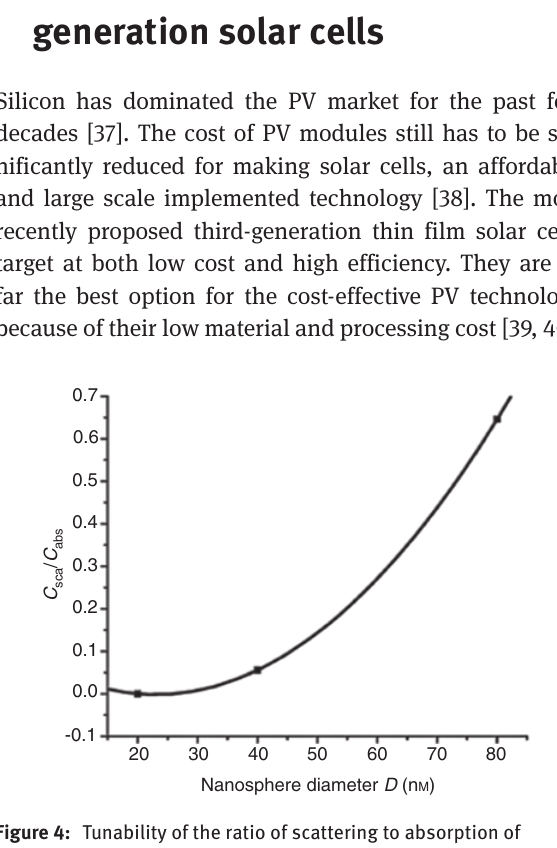
Figure 4: Tunability of the ratio of scattering to absorption